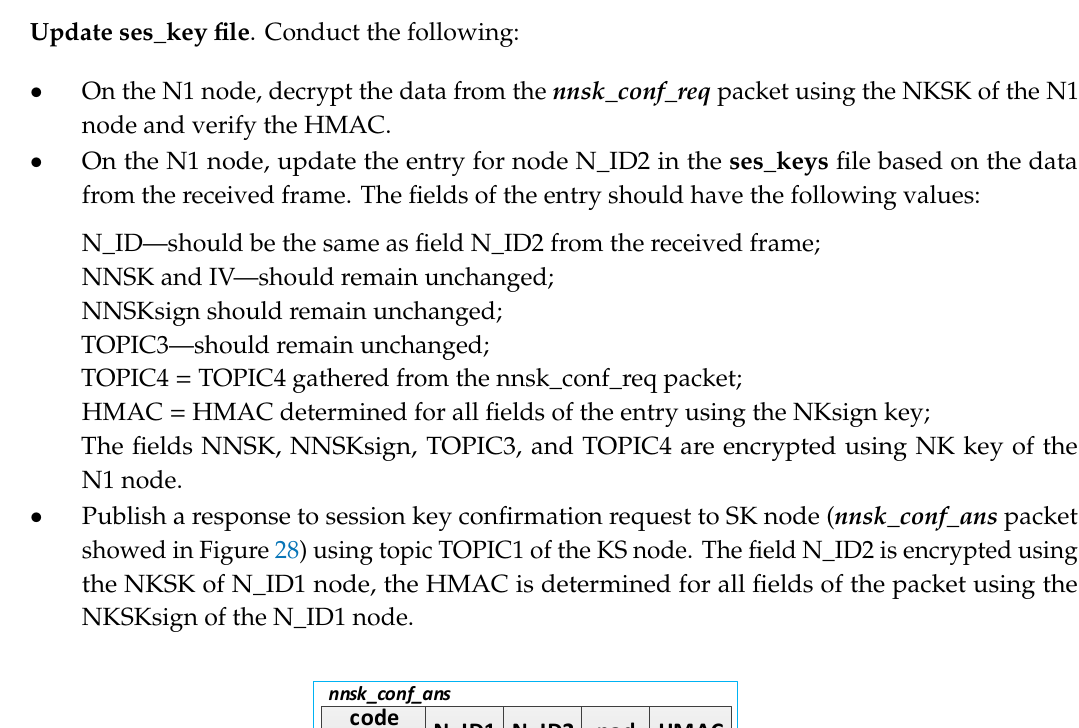
Figure 28. The response to the frame of session key confirmation request.